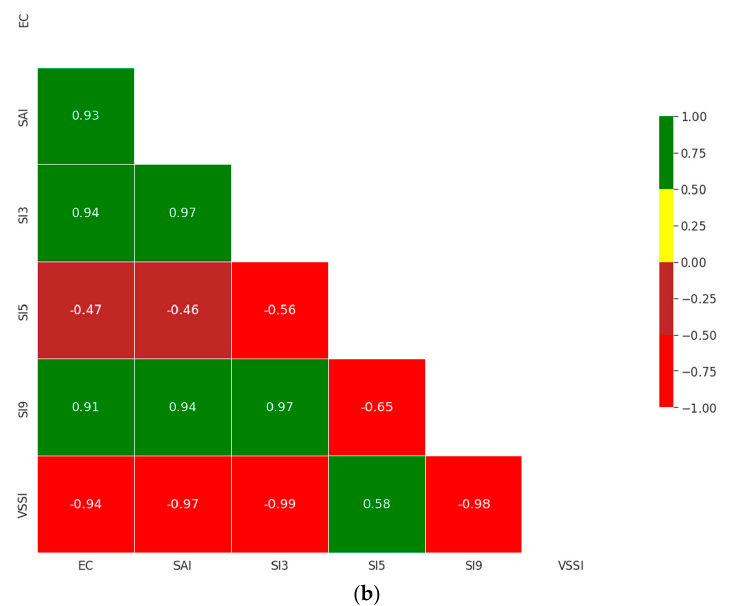
Figure 4. ( a ) The correlation between actual ECe and soil salinity indices. ( b ) The pair plot ( up ) and correlation ( down ) between the actual ECe and that extracted from satellite images.